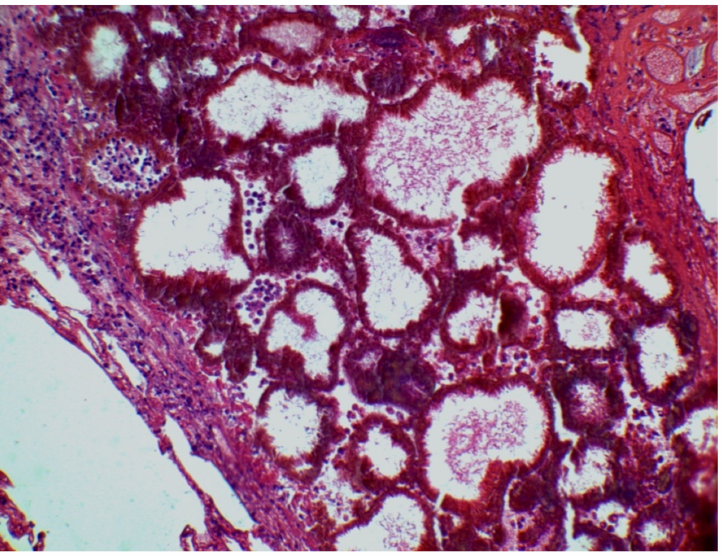
Figure 5. Lungs. The parenchyma appears widely hemorrhagic. Moreover, calcium deposits accumulate along the alveolar surface and partially obliterate the alveolar lumina (HE, magnification × 100). The presence of calcium deposits was confirmed by means of the Von Kossa staining method, which was carried out on 5- µ m-thick tissue sections using nuclear fast red (Bio- Optica; Milano, Italy) for counterstaining (Figure 6).